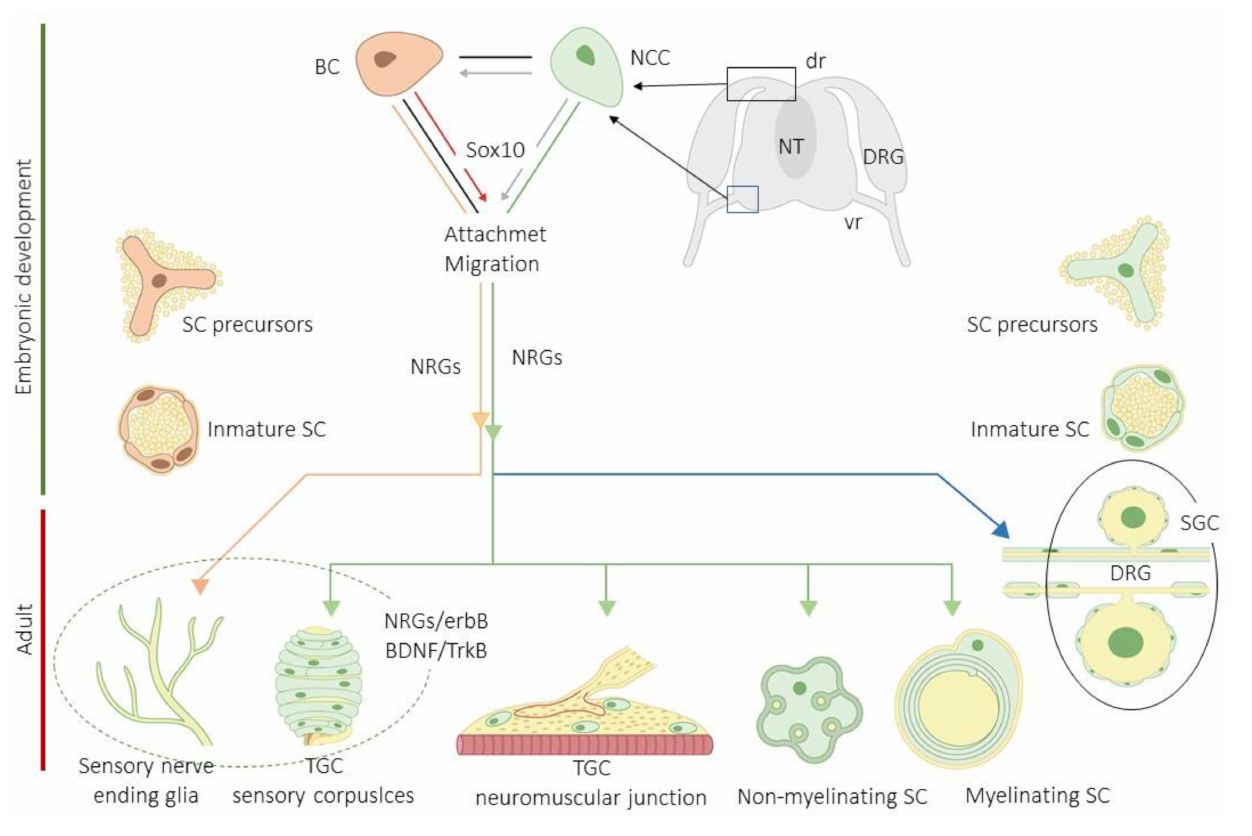
FIGURE 2 | Schematic representation of development and differentiation of peripheral glial cells subtypes. BC, boundary cells; BDNF, brain-derived neurotrophic factor; DRG, dorsal root ganglia (dr, dorsa root; vr, ventral root); erbBs, neuregulin receptors; NCCs, neural crest cells; NRGs, neuregulins; NT, neural tube; SCs, Schwann cells; SGCs, satellite glial cells; TGCs, terminal glial cells; TrkB, high affinity receptor for BDNF. Imitated from Kastriti and Adameyko